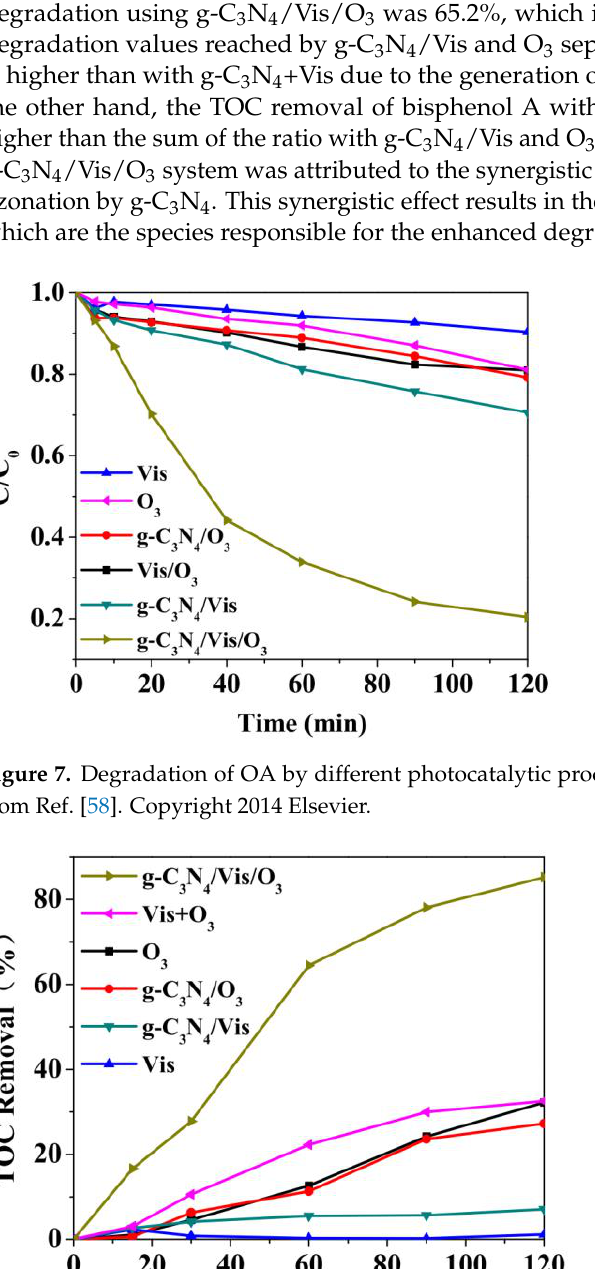
Figure 6. Degradation of OA by various oxidation processes upon g-C 3 N 4 ( A ) and Cl/g-C 3 N 4 ( B ). Reproduced with permission from ref. [57]. Copyright 2015 Elsevier.